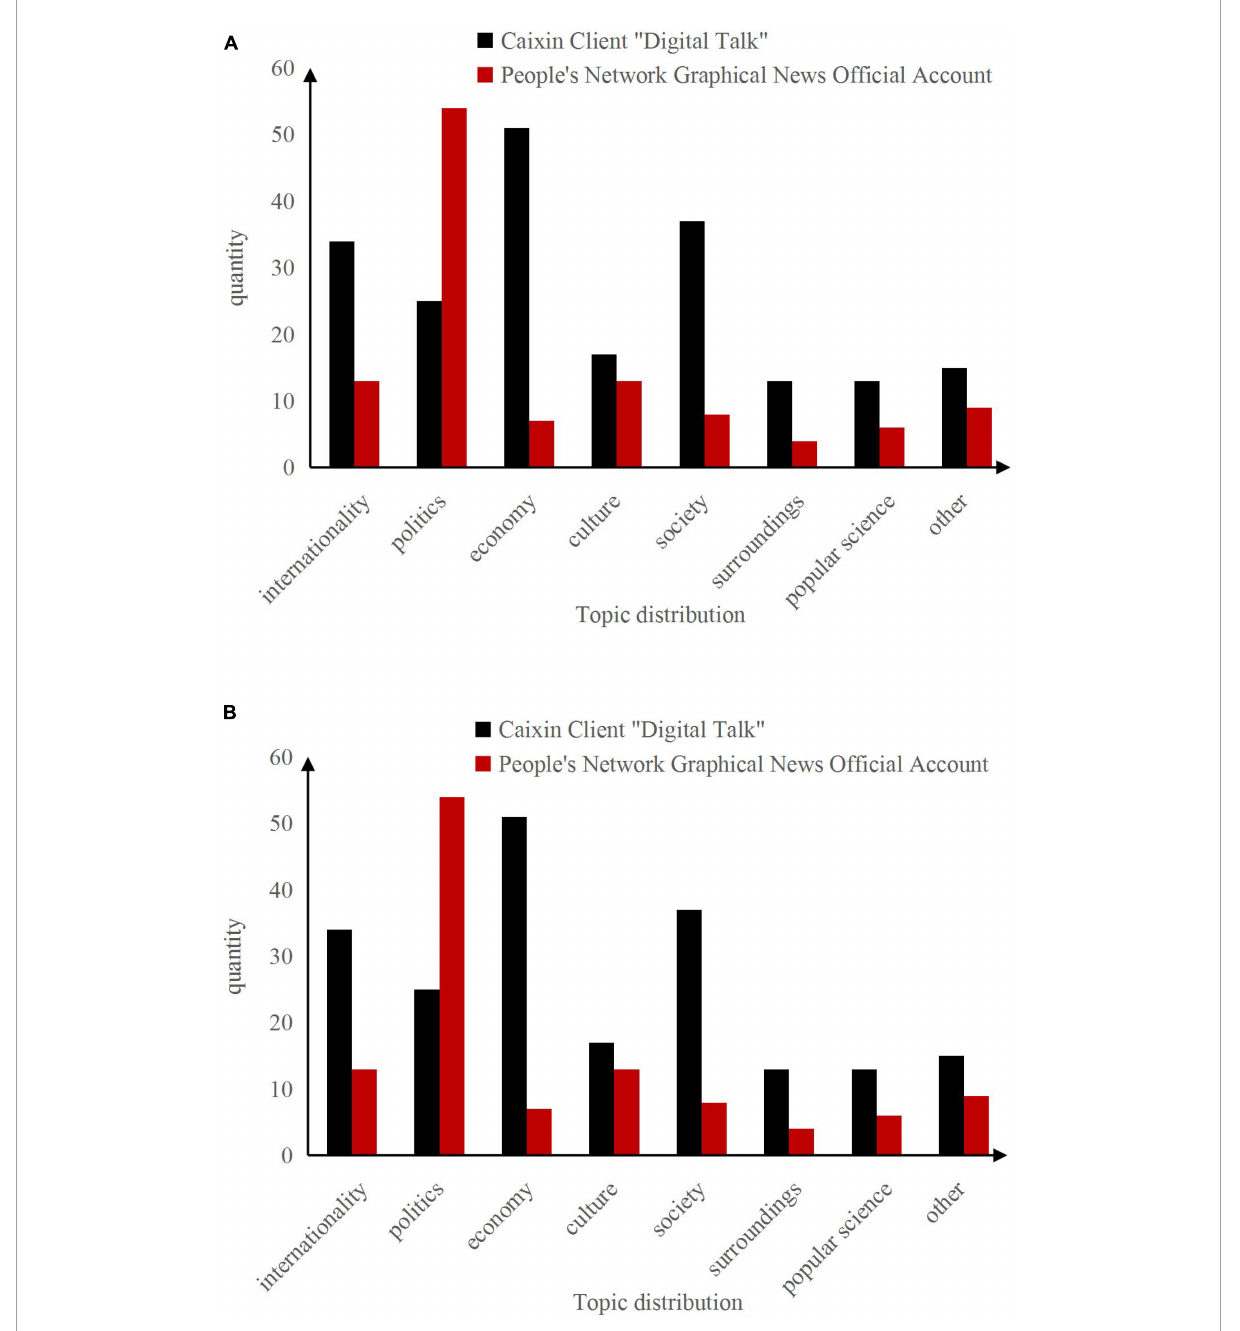
FIGURE6 Topic distribution. (A) Distribution of topics selected by the Caixin client “Digital Talk” and the people’s daily online graphic news official account. (B) Distribution of topics selected by NetEase digital reading Weibo, official account and